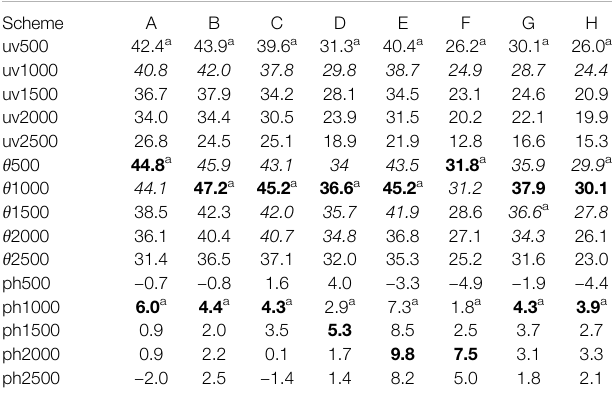
a indicates the optimal scheme in